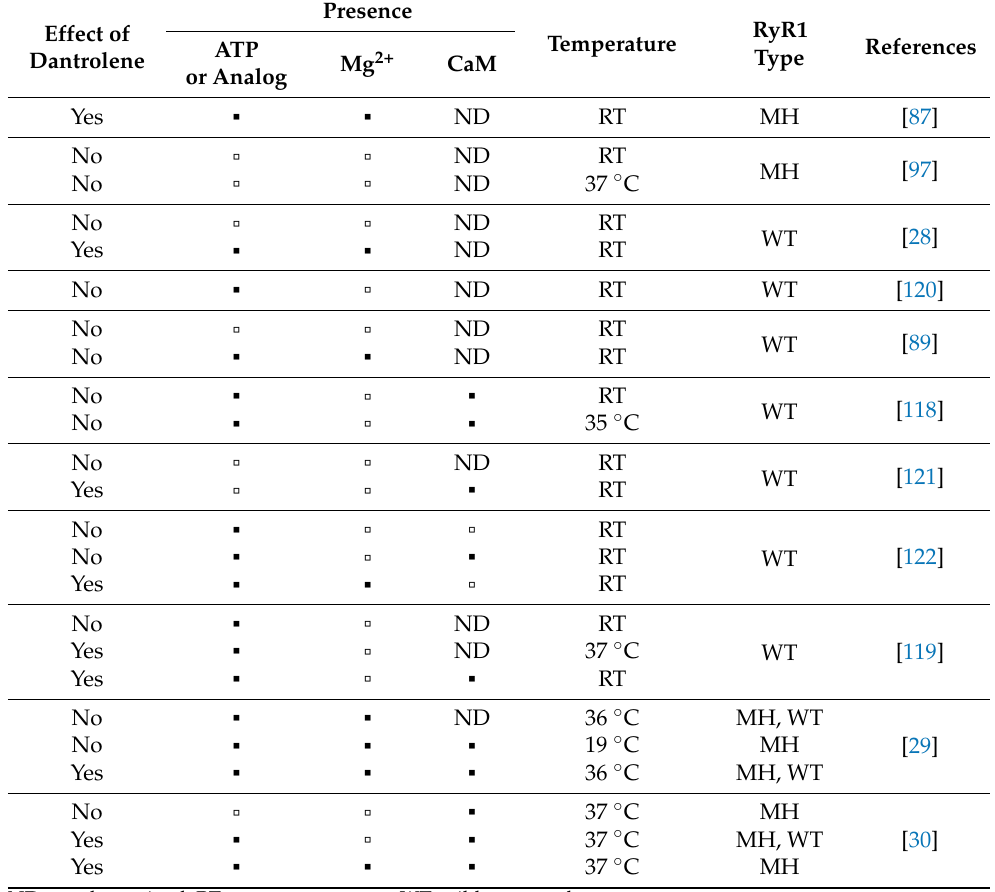
Table 1. Effect of dantrolene on the RyR1 channel in cell-free experiments. ATP, Mg 2+ , CaM, and dantrolene were added to the RyR1 cytosolic face.